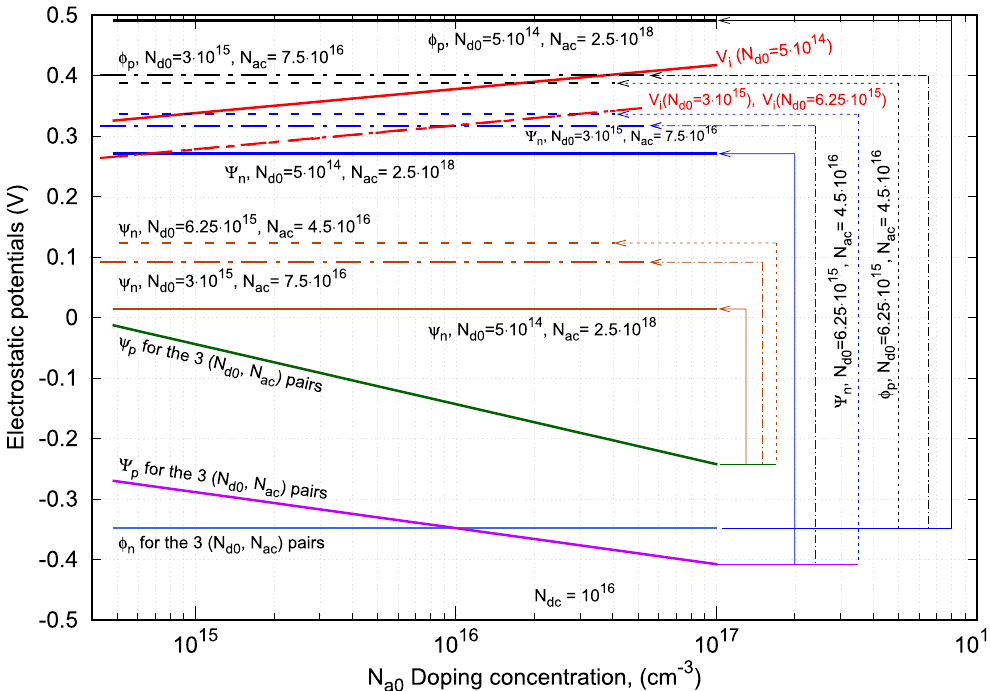
Figure 3. Variations of the electrostatic potentials and the electrostatic voltages with p -type leg doping concentration for a given doping concentration of the emitter at the cold-end of the n -type leg and three n -type leg doping concentrations and their corresponding doping concentrations of the emitter at the cold-end of the p -type